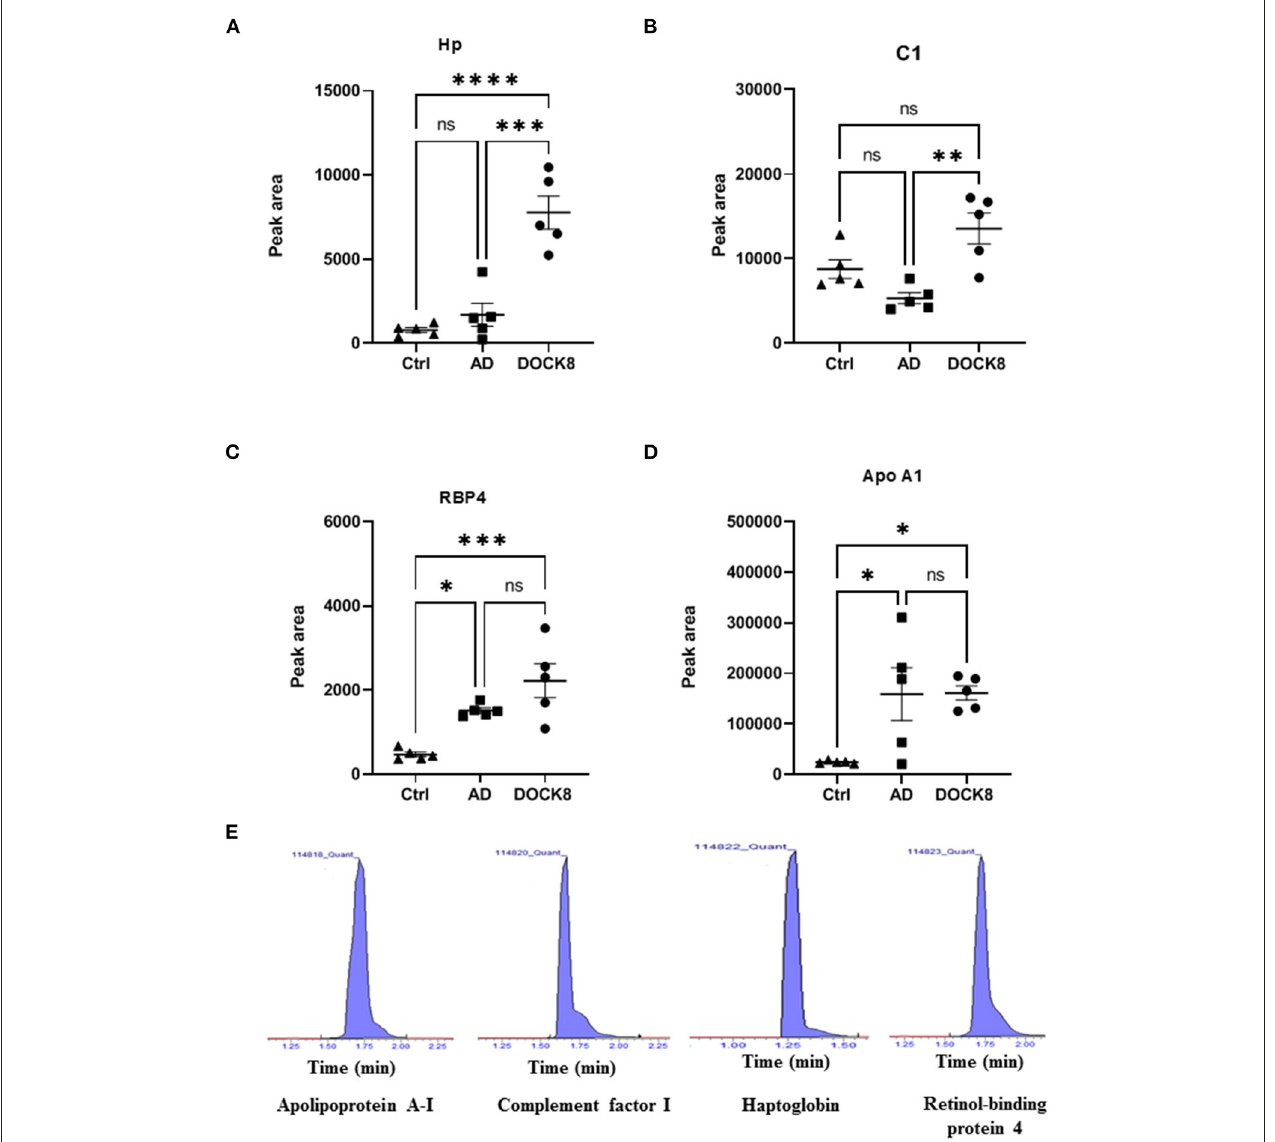
FIGURE 4 | Multiple reaction monitoring (MRM) mass spectrometry for method validation using representative proteins. The MRM method based on signature peptides was developed to validate the expression of four representative proteins (A) Hp, Haptoglobin (B) C1, complement factor 1 (C) RBP4, retinol-binding protein 4, and (D) ApoA1, apolipoprotein A-1, found in the proteomics analysis. (E) Representative-extracted ion chromatograms for the signature peptides of the four proteins based on the MRM method developed for validation. The expression of these four proteins in patients with DOCK8-deficiency was expressed in the peak area. The statistical significance was evaluated using an unpaired t -test, in which *p < 0.05, **p < 0.01, ***p < 0.001, and ****p <